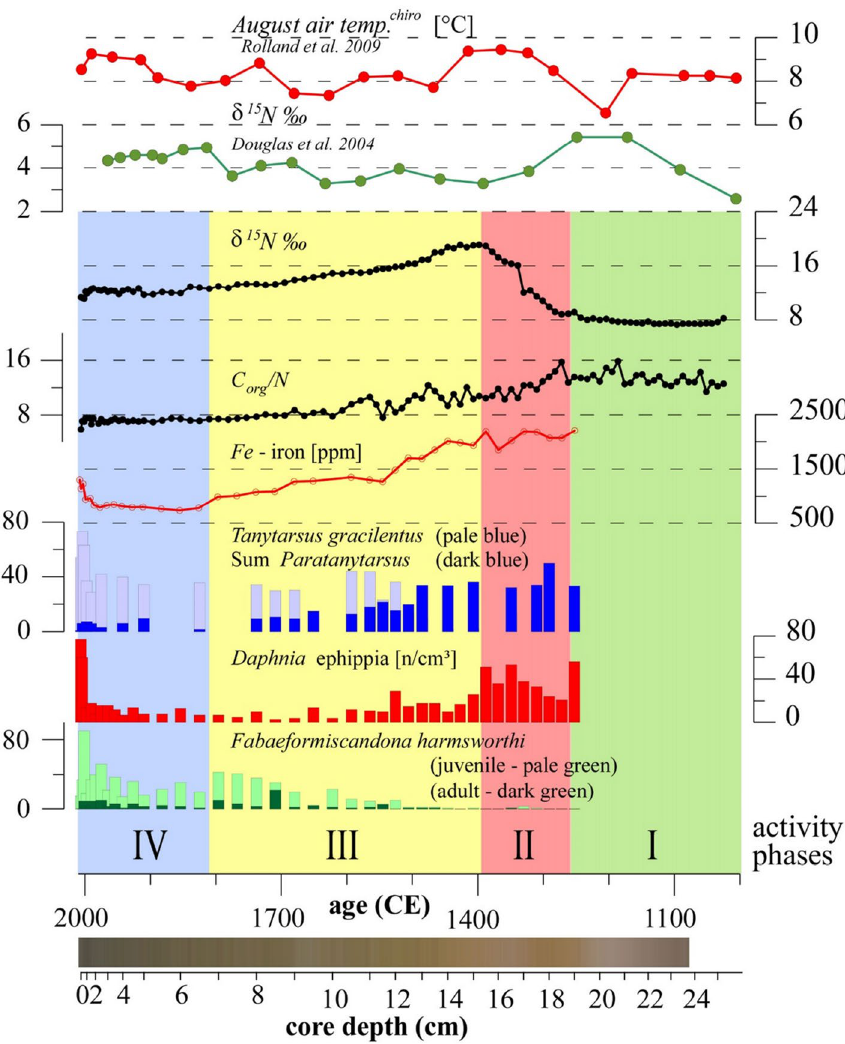
Figure 3. Nitrogen isotope analysis from paleo-Inuit harvesting sites and distinguishable phases at Bung Stick Pond cores. Inferred August air temperature based on chironomid remains from Southampton Island 19 . Earlier pronounced stable δ 15 N isotope record from sediment core tracingprehistoric Inuit whalers on Somerset Island 15 . Stable δ 15 N isotope record and TOC:TN-ratio from bulk sediment samples of core NP-3; iron (Fe) record from bulk sediment samples of core NP-2; selected relative abundance of chironomids of core NP-2, with Tanytarsus gracilentus (pale blue) and sum percentage of Paratanytarsus (dark blue); enumerated Daphnia ephippia (resting eggs) and Fabaeformiscandona harmsworthi (Ostracoda) valves of core NP-2 in individuals per cm 3 with; adults (dark green), juveniles (pale green); interpreted activity phases I–IV at Native Point; sediment colors of age-corrected core